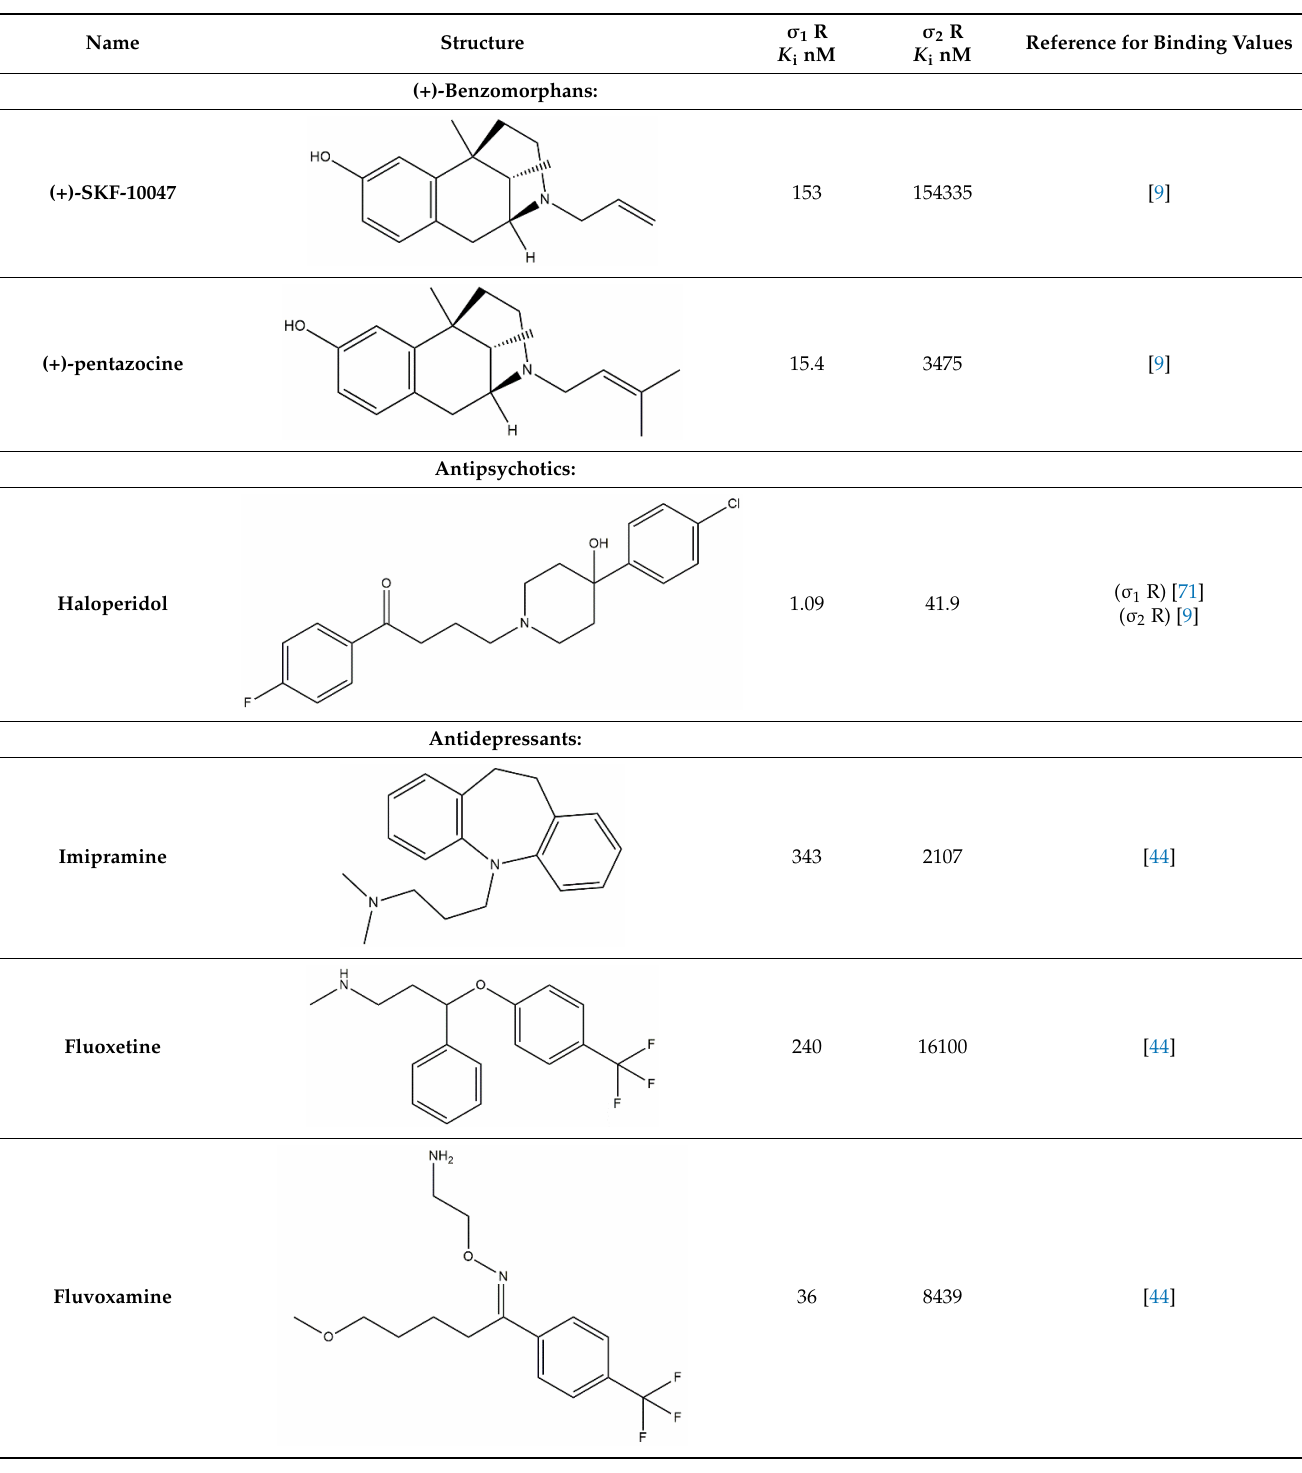
Table 1. Representative σ 1 receptor ( σ 1 R) ligands and their affinities for σ 1 R and σ 2 receptor ( σ 2